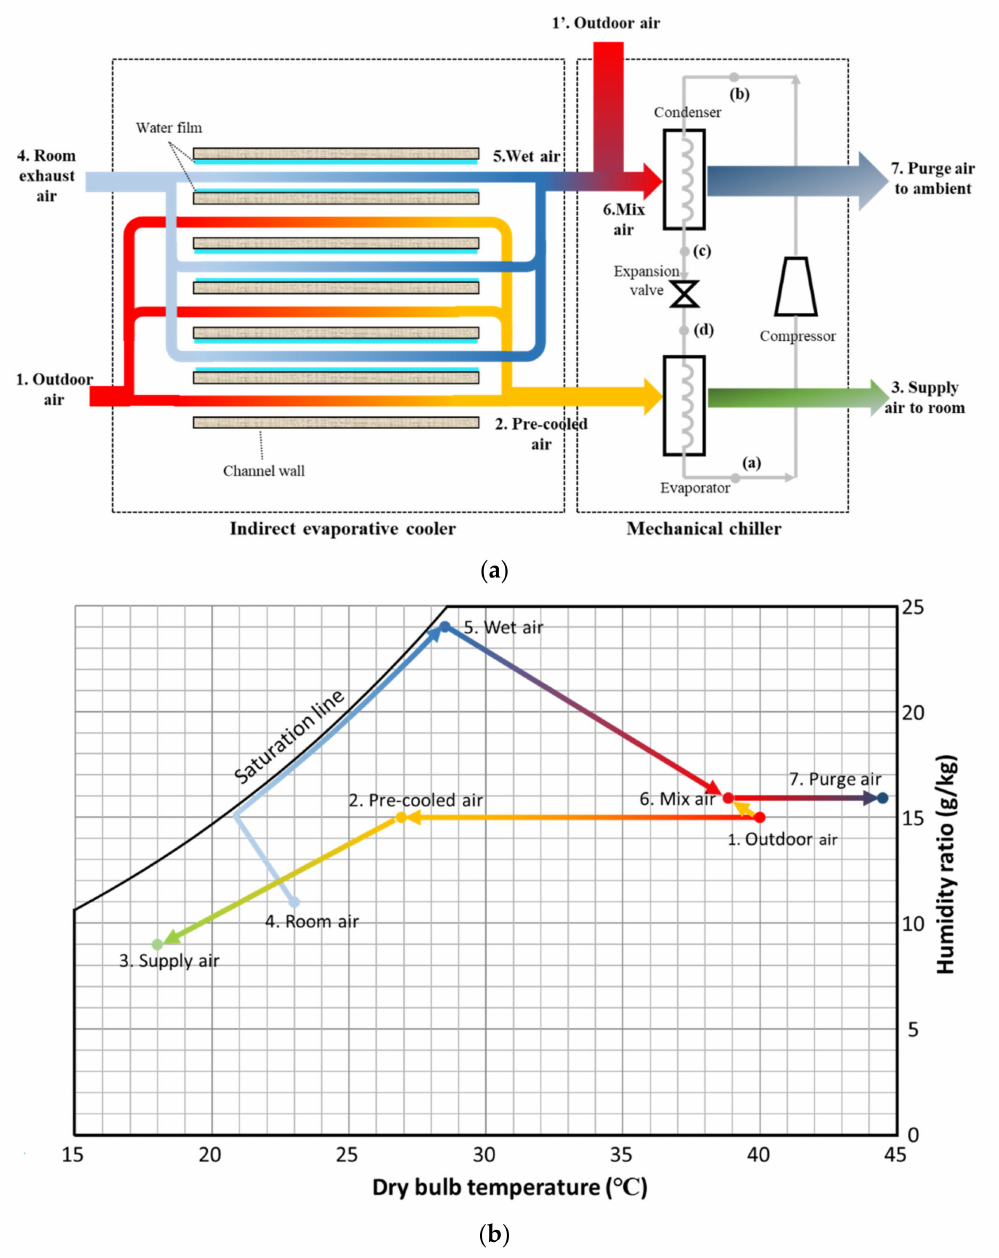
Figure 4. The hybrid IEC-MVC process: ( a ) schematic and ( b ) psychrometric chart demonstration